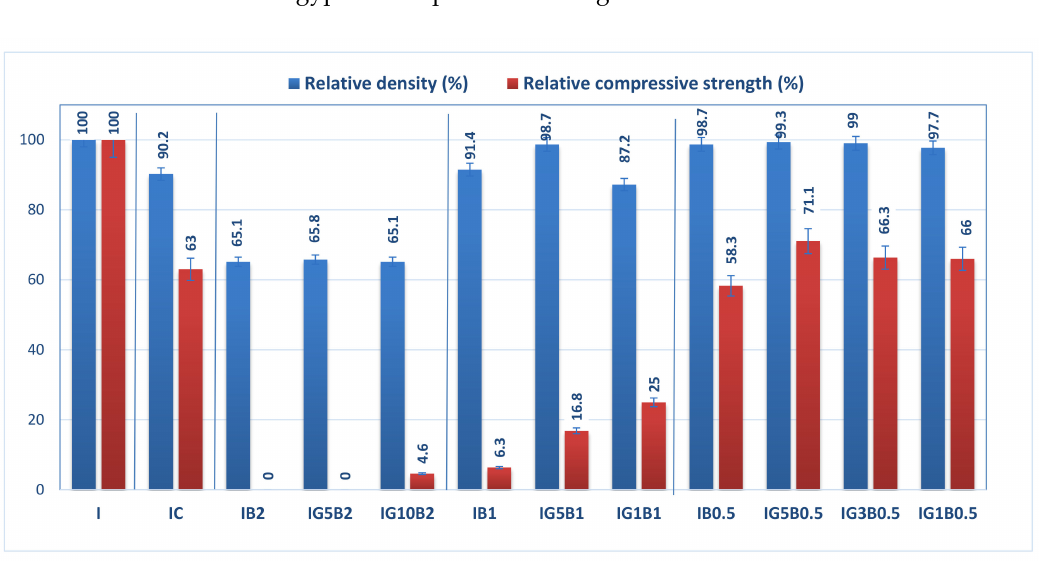
Figure 3. Influence of FGD gypsum (G), sodium bicarbonate (B) and HEMC (C) additions on the normalized geometrical density and compressive